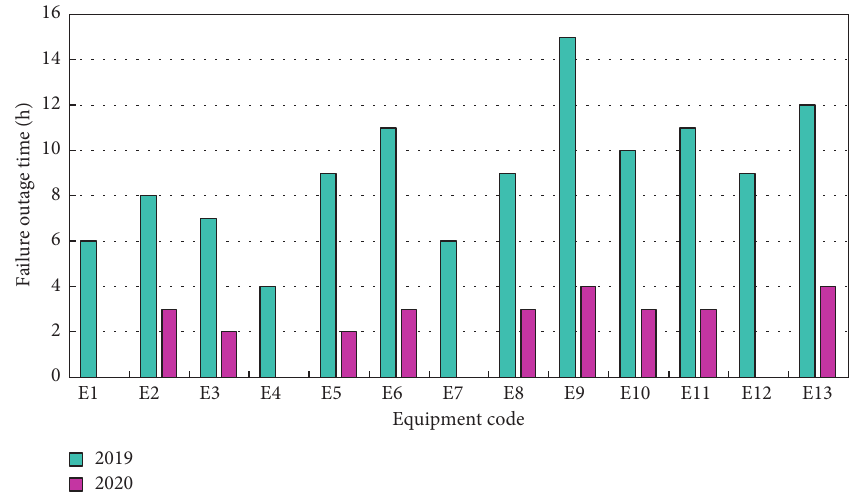
Figure 8: Comparison results of fault outage time before and after use of monitoring